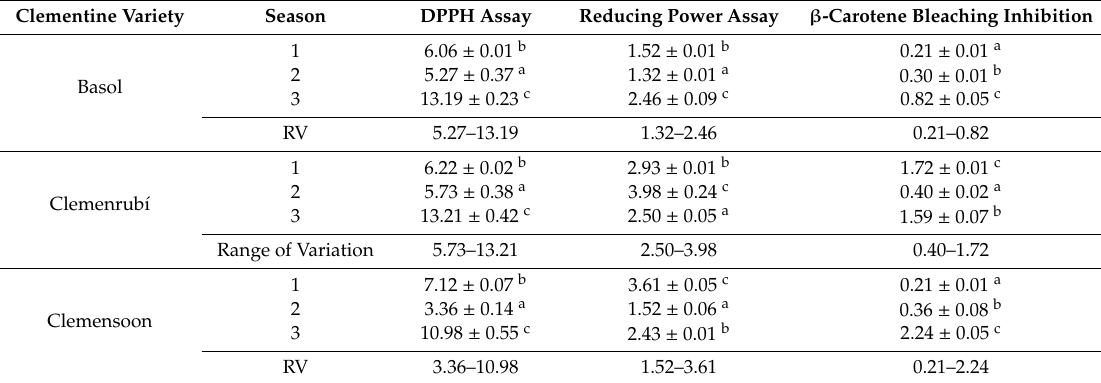
Table 9. Antioxidant activity of the methanolic extracts (EC 50 , mg / mL methanolic extract) of the three studied extra early clementine varieties (mean ± SD, n =